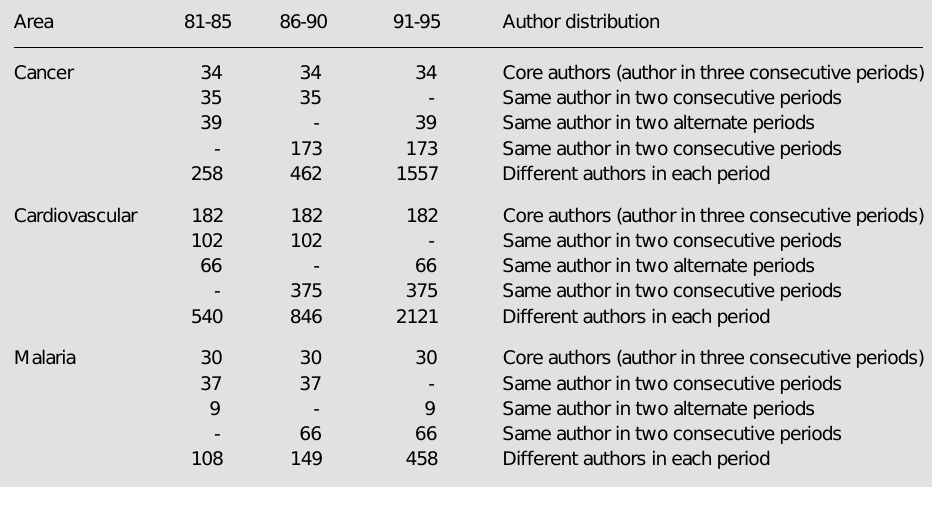
Table 1 - Authors grouped into five-year periods. Numbers in columns do not overlap. Core authors: Numbers of authors appearing in articles published during the three periods.